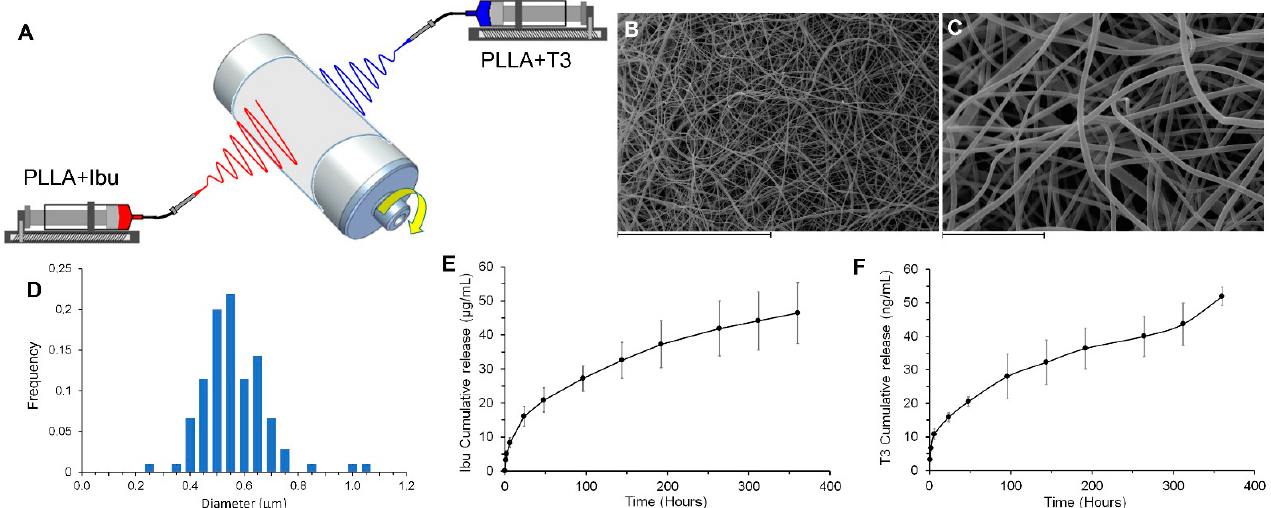
Figure 5. ( A ) Scheme of co-electrospinning instrumental set-up for the production of the dual-drug delivery electrospun system consisting of a fibrous scaffold composed of PLLA fibers loaded with Ibu at 5 wt% and of PLLA fibers loaded with T3 at 0.6 wt%. ( B , C ) SEM images of the delivery system at different magnifications (Scale bars: 60 µm ( B ) and 10 µm ( C )); ( D ) fiber diameter distribution. ( E ) Ibu cumulative release in PBS over 400 h; ( F ) T3 cumulative release in PBS over 400 h.